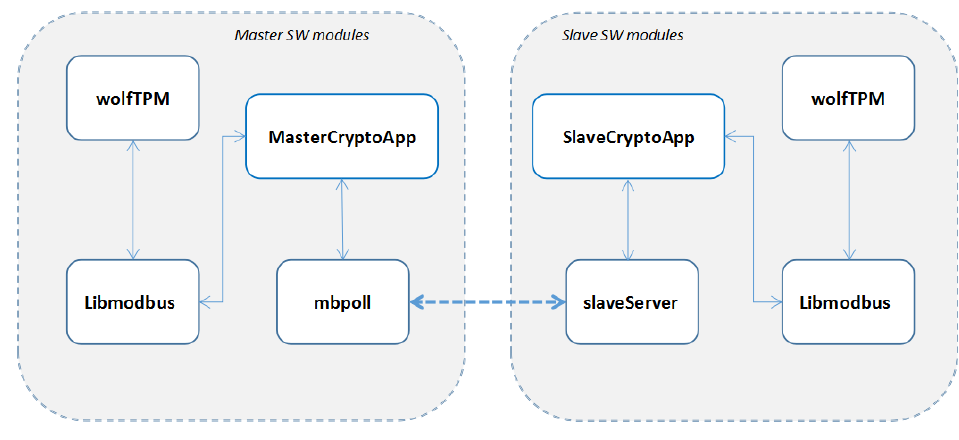
Figure 4. Software application modules.